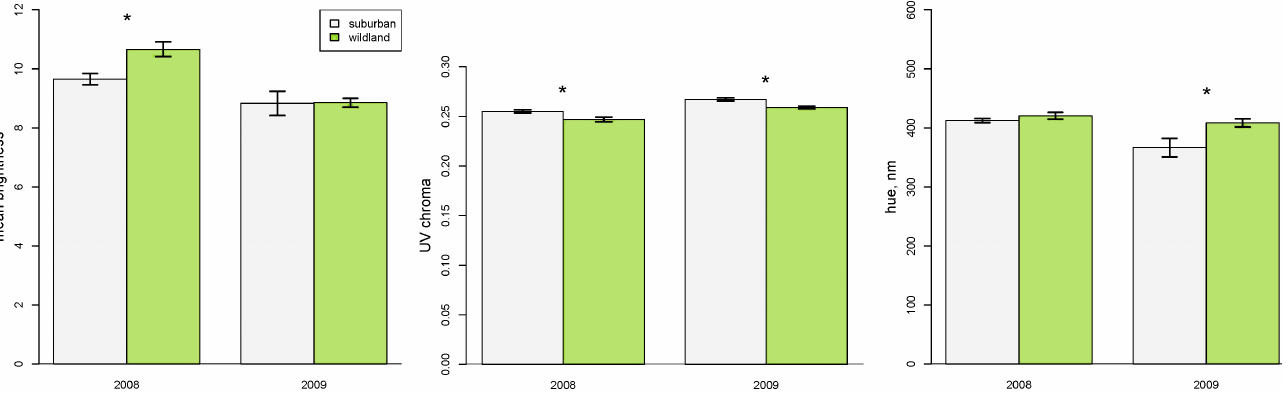
Fig. 1. Mean and SE of mean brightness, UV chroma, and hue for suburban (gray) and wildland (green) Florida Scrub-Jay juveniles.